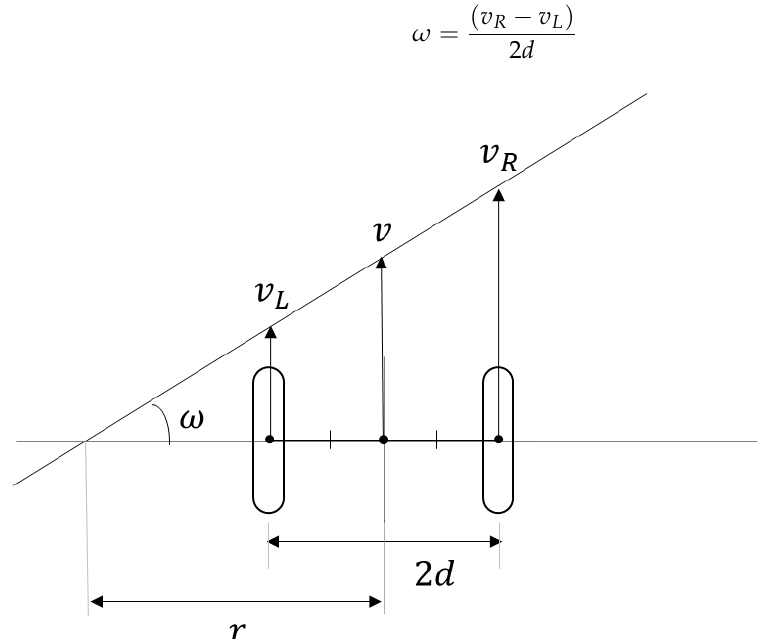
Figure 6. Schematic diagram of a vehicle in a left turn.